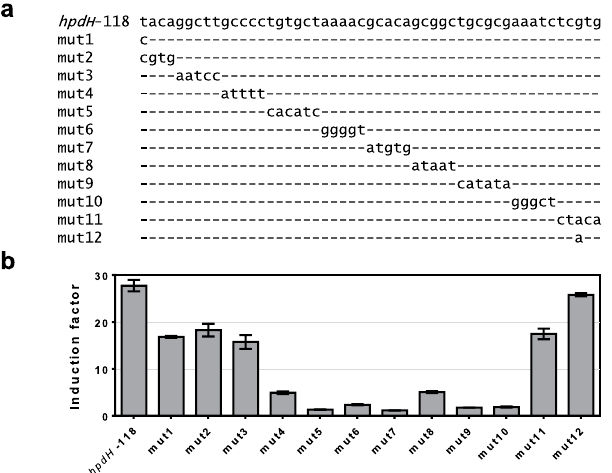
Figure 3. P. putida KT2440 hpdH -118:: rfp promoter mutations. ( a ) Schematic illustration of the different hpdH -118:: rfp promoter mutations that were evaluated for 3-HP-responsive activation of rfp reporter gene expression. Unchanged nucleotides are represented as dash. ( b ) Induction levels mediated by the different promoter mutations. The various promoter-reporter gene constructs were analysed in E. coli MG1655 for RFP expression in the absence or presence of 10 mM 3-HP. Error bars represent standard deviations of three biological